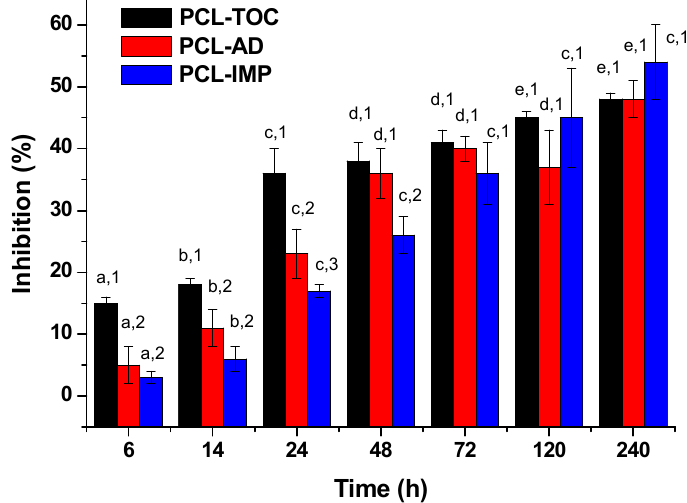
Figure 6. ABTS results of migration extracts determined by ATBS method (mean ± SD; n = 3). Di ff erent numbers (1, 2) at the same time indicate statistically di ff erent values between formulations ( p < 0.05) and di ff erent letters (a, b, c, d, e) at the same formulation indicate statistically di ff erent values between times ( p < 0.05).